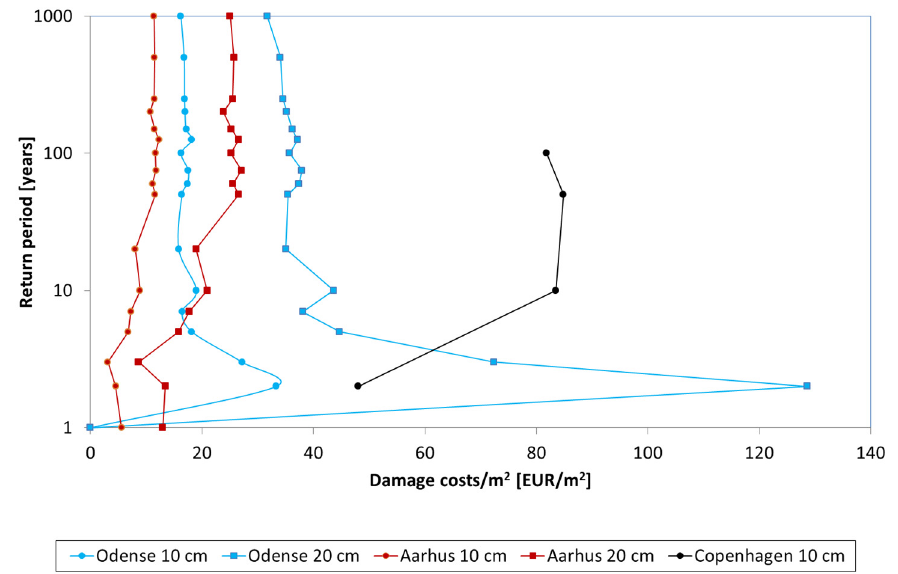
Figure 13. Damage costs/m 2 for the two areas in Aarhus and Odense compared to the cost in Copenhagen. Each point on the line represent a specific return period from T = 1 to T = 1000